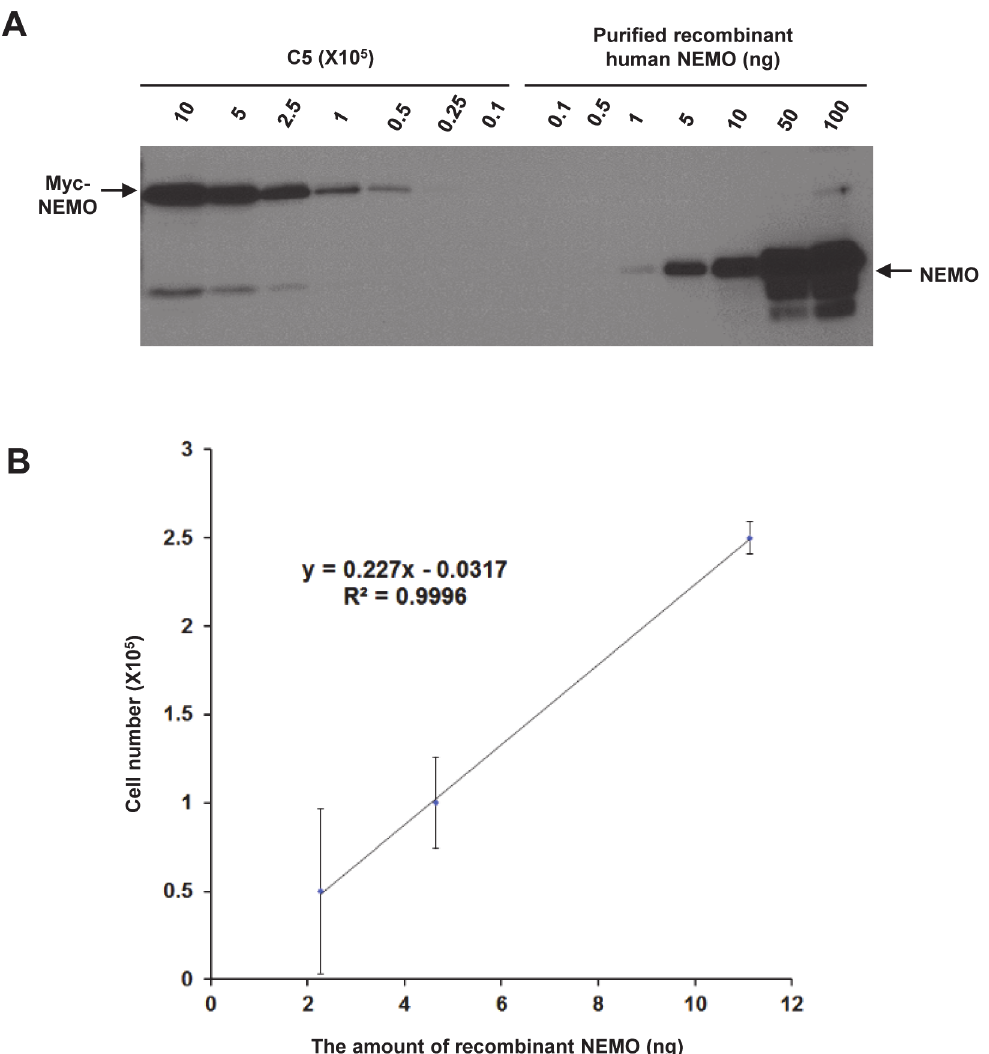
Fig 2. Determination of the average number of NEMO molecules in the C5 clone. (A) Protein extracts from the indicated number of C5 cells and indicated amount of purified recombinant human NEMO proteins were separated on SDS-PAGE gel and immunoblotted with NEMO antibody. (B) Graph representing the intensity of the bands corresponding to NEMO in three independent replicates as shown in (A) and an equation derived from the graph. Error bars represent S.E.M.